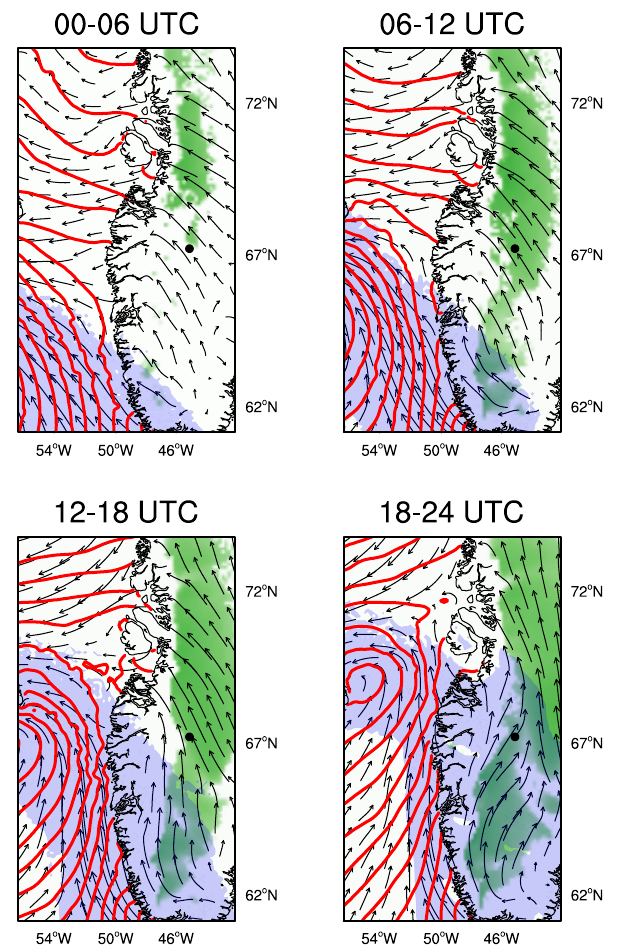
Fig. 8. Time evolution of the large-scale weather situation on 24 September 2012, with sea-level pressure (red lines), 10m wind (black arrows), precipitation (shaded blue if > 1mm w.e. per 6h) and vertically integrated drifting snow transport (shaded green if > 6000kgm − 1 per 6h). The location of S10 is indicated by the black dot in each